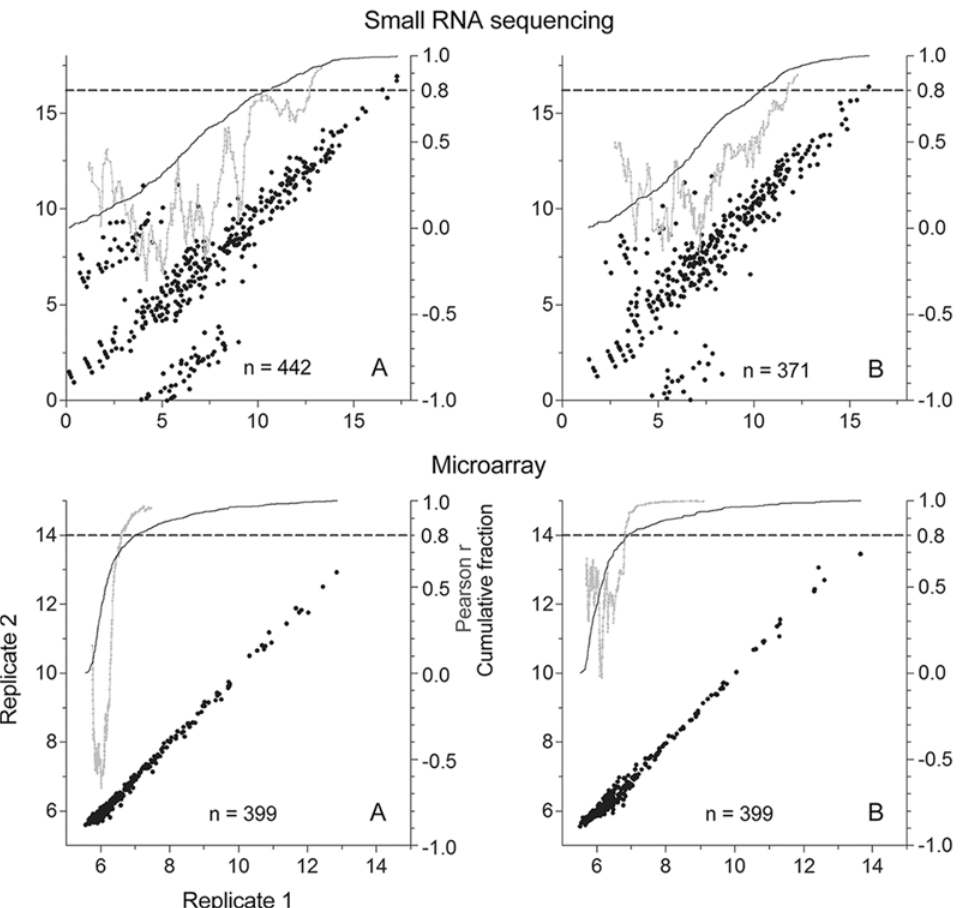
Fig 2. Inter-replicate correlations. MicroRNAs in 2 samples ( A and B ) were profiled in duplicate by both the small RNA sequencing and microarray platforms. Scatter-plots depict the inter-replicate correlation of normalized microRNA measurements. The cumulative fraction of microRNAs along the X axis ( black ), and the values of Pearson correlation coefficient of the microRNA measurements in a sliding window along the X axis of size 51 at mid-window ( gray ) are also shown.